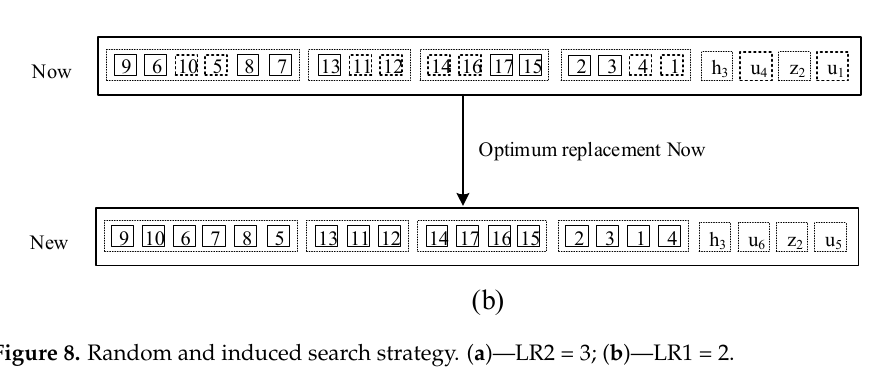
Figure 8. Random and induced search strategy. ( a ) — LR2 = 3; ( b ) — LR1 = 2.